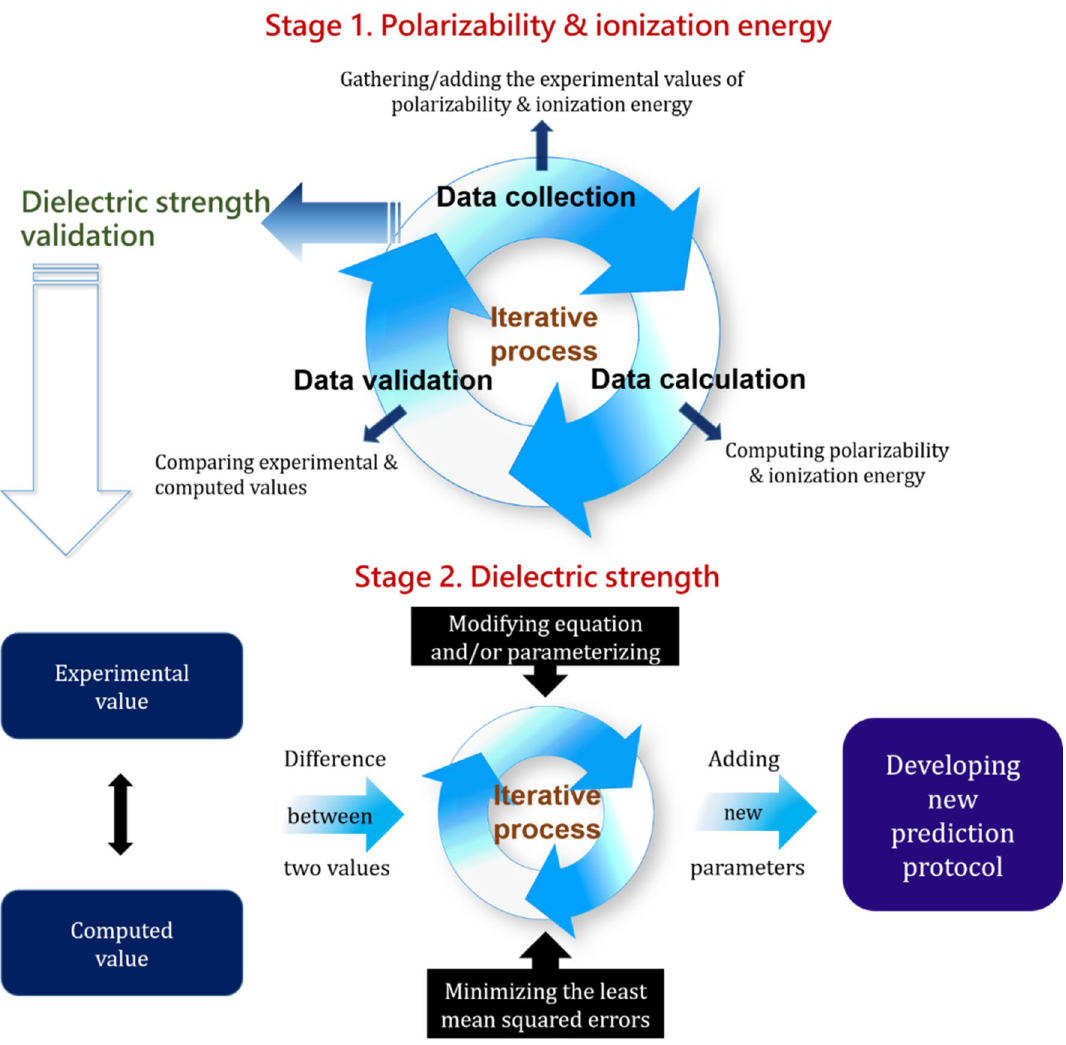
Figure 1. Designed computational protocol. Schematic illustration of developing a computational protocol to predict reliably the dielectric strengths of organic